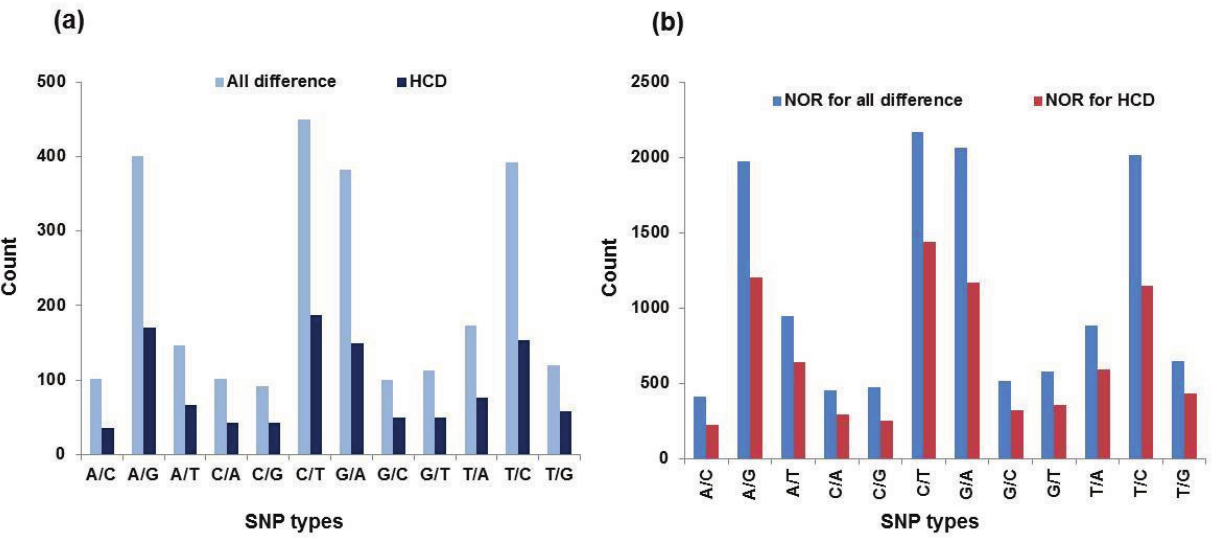
Figure 5. Distributions of single nucleotide polymorphism (SNPs) in Vicia sativa nigra and